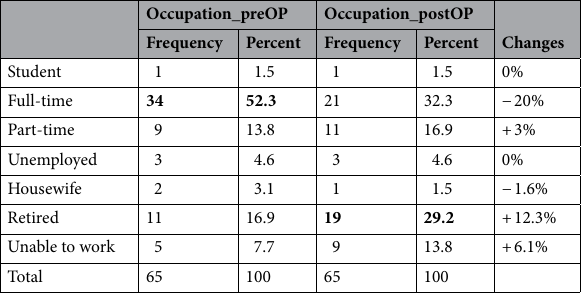
Table 3. Assessment of pre- and postoperative professional occupation. Note the shift from full-time employment to patients who retired and/or were unable to work (+ 12.3 and +